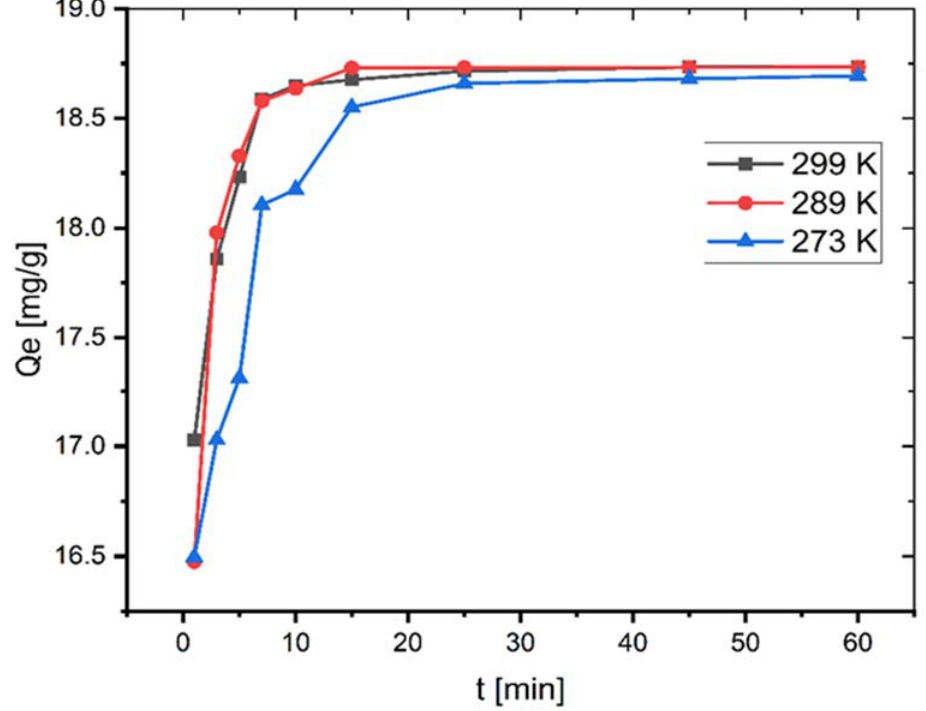
Figure 4. Effect of temperature on adsorption of MB onto coal ( C 0 = 100 mg L − 1 ; mass of coal = 0.1 g; volume of MB solution = 25 mL; pH = 6.35).